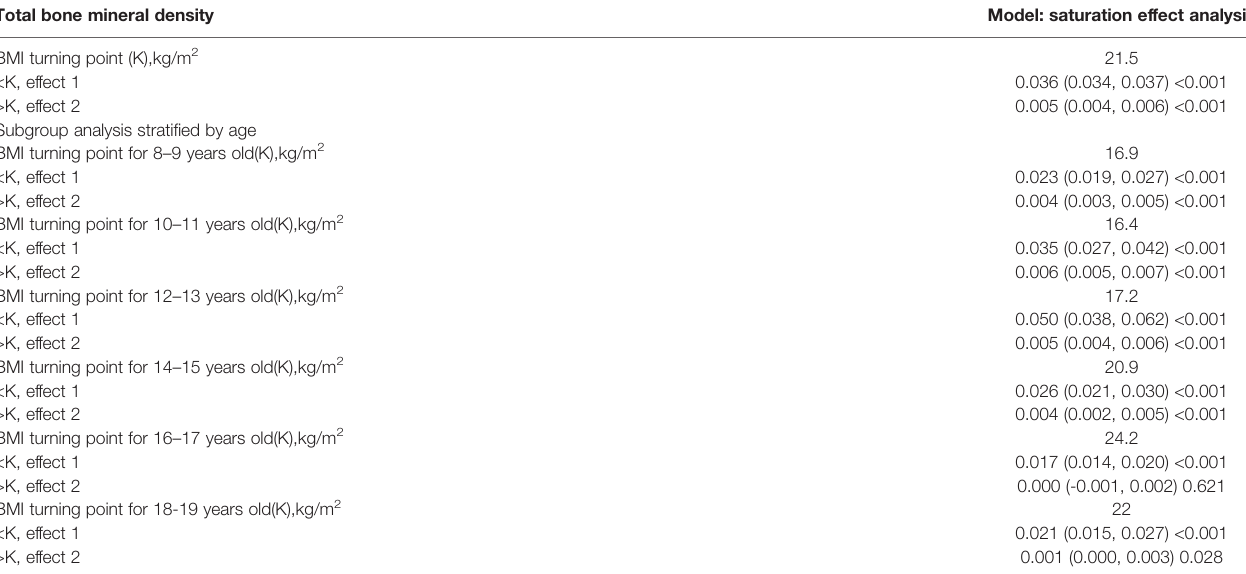
TABLE 3 | Saturation effect analysis of BMI (kg/m 2 ) on total BMD (g/cm 2 ). Total bone mineral density